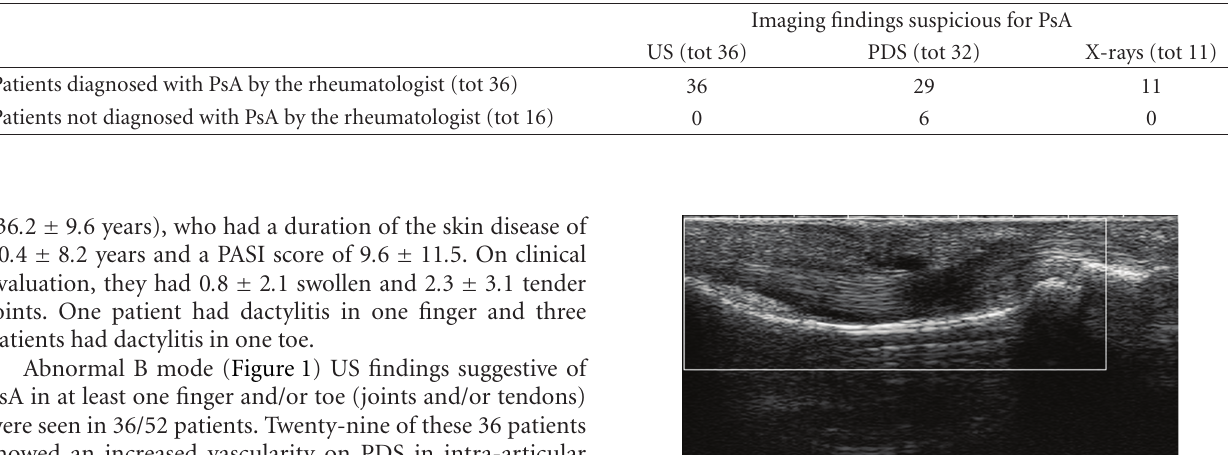
Table 2: Results of gray-scale US, PDS, X-rays, and rheumatological evaluation of 52 psoriatic patients with suspected psoriatic arthritis of fingers and/or toes.